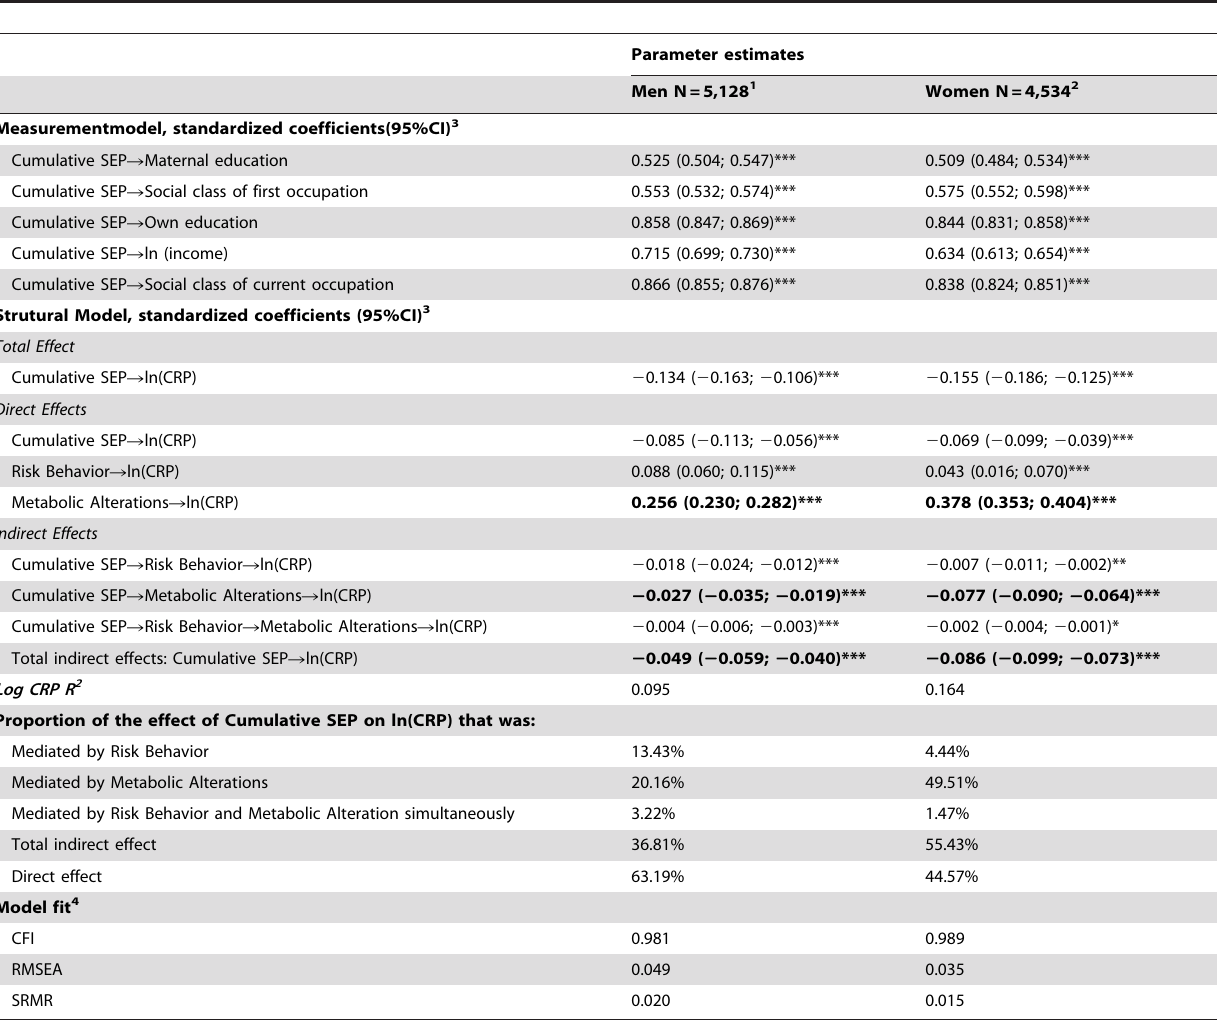
Table 5. Parameters estimates from the structural equation model of cumulative SEP on CRP levels in adulthood, according to